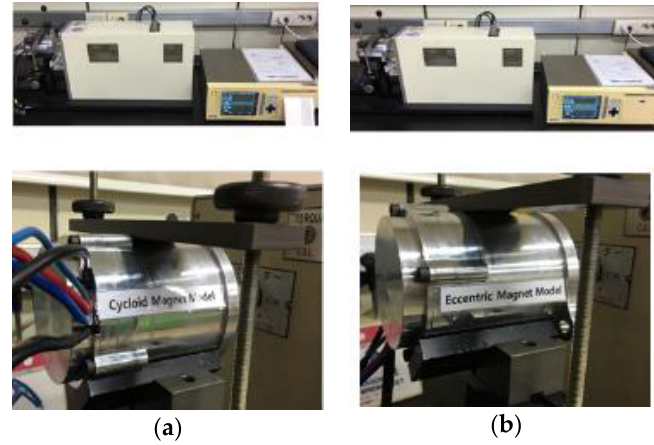
Figure 14. Cogging torque test for prototype: ( a ) cycloid; ( b ) eccentric.